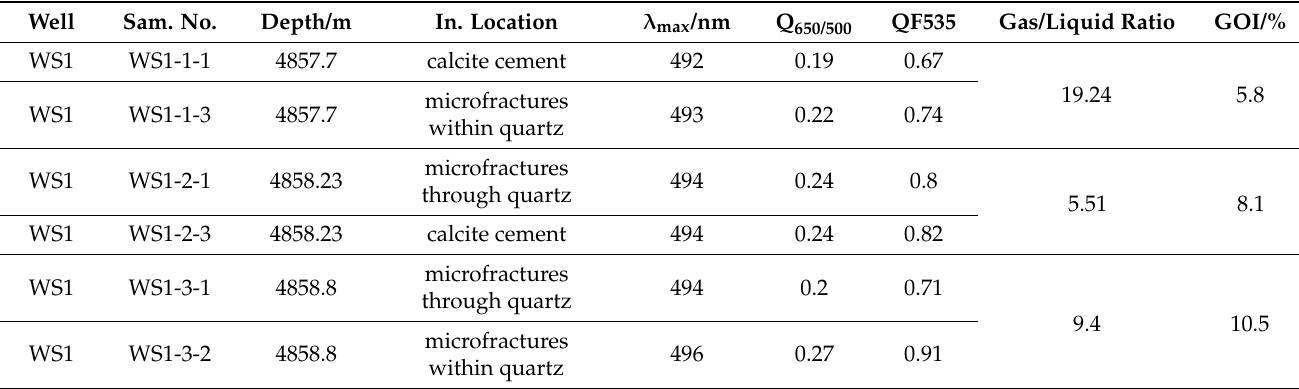
Table 1. Spectral parameters of petroleum inclusion fluorescence, laser confocal gas/liquid ratio, and grain with oil inclusions (GOI). Well Sam.